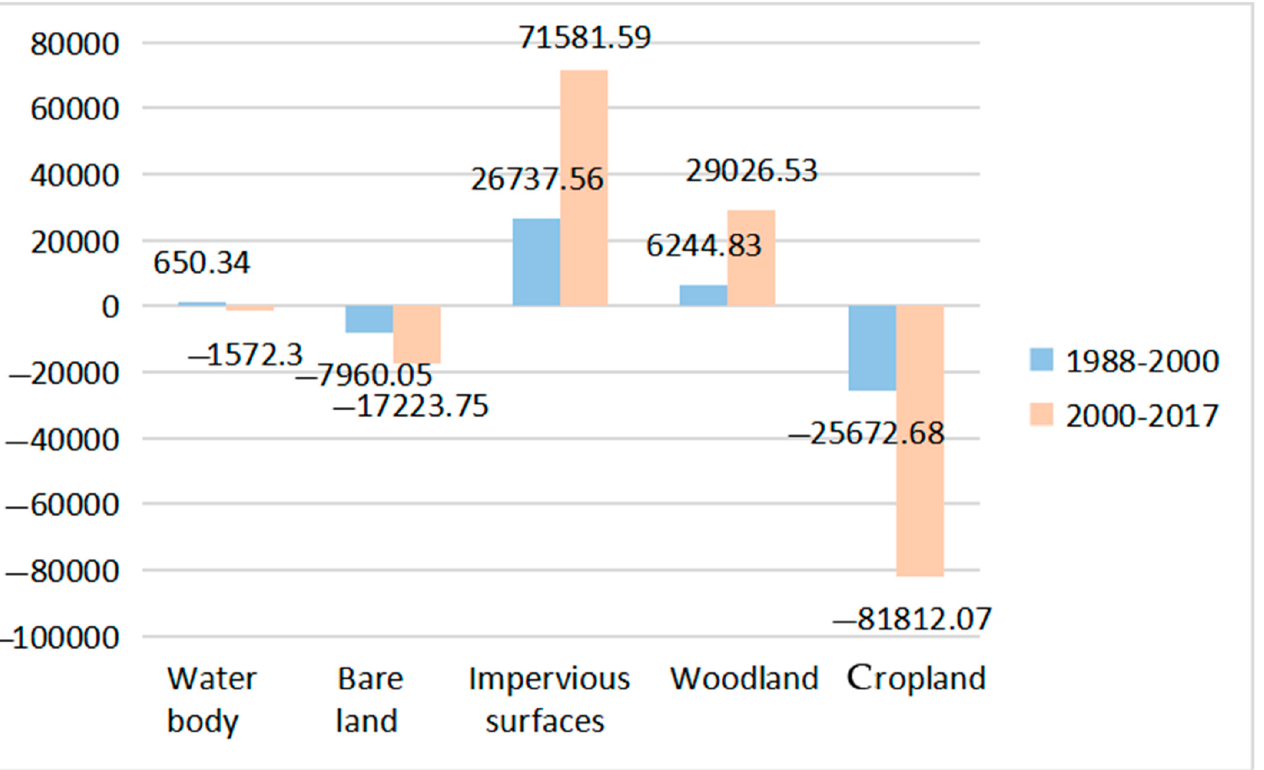
Figure 3. The net change in landscape area in the study